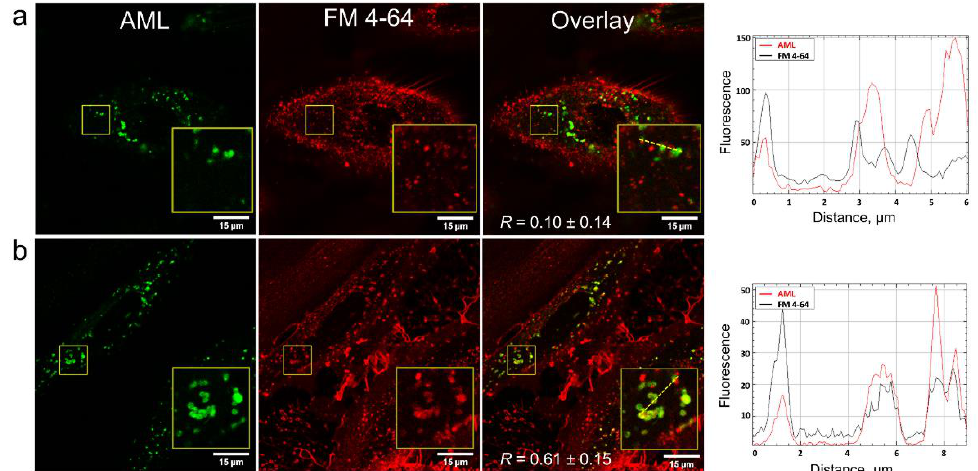
Figure 5. Confocal images showing live A7r5 cells counterstained with AML (green) and FM 4-64 (red). Cells were incubated for 15 min at 37 °C in HBSS/HEPES containing 300 nM AML and 5 mM FM 4-64 dye and imaged in HBSS in confocal SP8 microscope immediately after ( a ) or after 75 min ( b ). Whole cells and selected ROIs 12 × 12 μm are shown. Pearson’s co-localization coefficients ( R ) mean ± S.D. were determined using ImageJ 1.53c software from seven ROIs 2 × 2 µm containing AML signal. The line profiles were taken across the yellow dashed lines (AML—red, FM 4-64—black) and calculated using ImageJ 1.53c software.